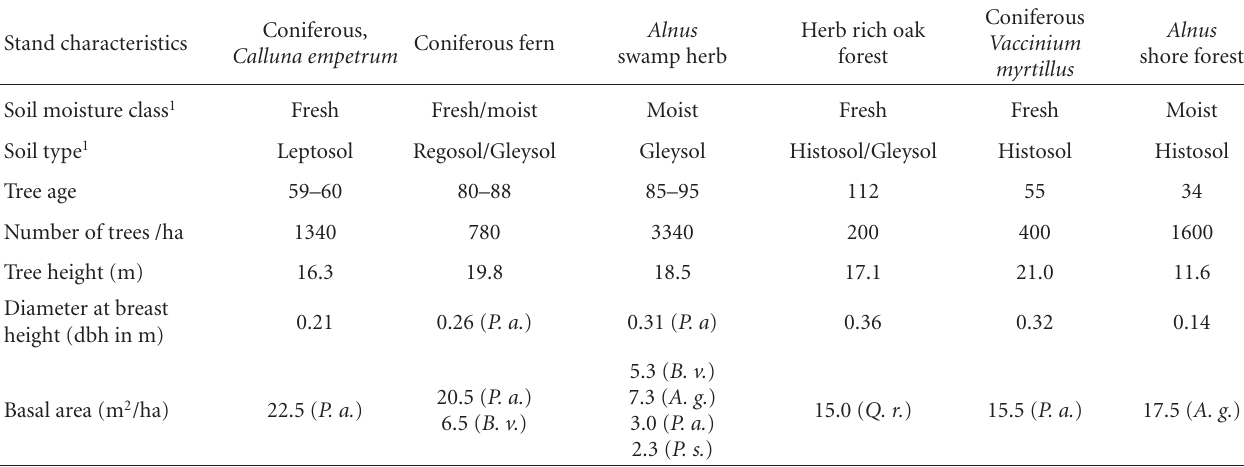
Table 1: Site and stand characteristics at Forsmark and Laxemar. Picea abies = P. a. , Pinus sylvestris = P. s. , Betula verrucosa = B. v. , Alnus glutinosa = A. g. , Quercus robur = Q.